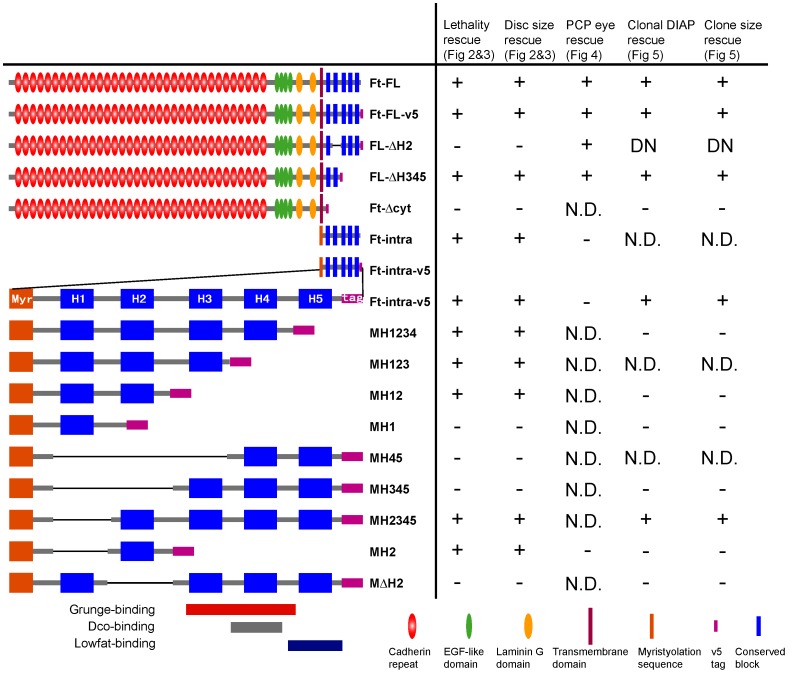
Summary of Ft constructs and their ability to rescue ft mutant phenotype.Schematic structure of Ft mutant constructs is on the left with their short names. (See Materials and Methods for details.) Summary of rescue results is on the right. Measurement and quantification of each rescue assay can be found in indicated figures. In the lethality rescue assay, effective rescue (+) was determined by at least 25% recovery of the expected number of ftG−rv/ftl(2)fd; TubP-Gal4/UAS-transgene adults, whereas no rescue (−) was determined for those transgenes which did not produce any adult animal (eclosion). In the eye disc size rescue assay, effective rescue (+) was determined by <20% increase of size compared to wt disc. In the PCP rescue assay, effective rescue (+) was determined by >85% correct orientation of ommatidia; (−) indicates disorganized polarity that the equator was unable to be recognized, and <75% correct orientation can be determined. In the clonal DIAP1 and clone size assays, effective rescue (+) was determined by >60% of clones with successful rescue of clonal phenotype and DIAP1 expression level. ‘DN’ indicates dominant negative effect of FL-ΔH2. N.D.: not determined.